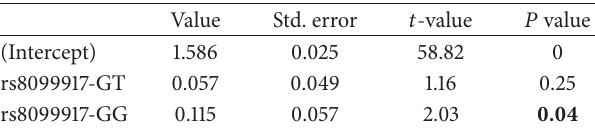
Table 7: Linear regression of serum IL28B levels with different fac-